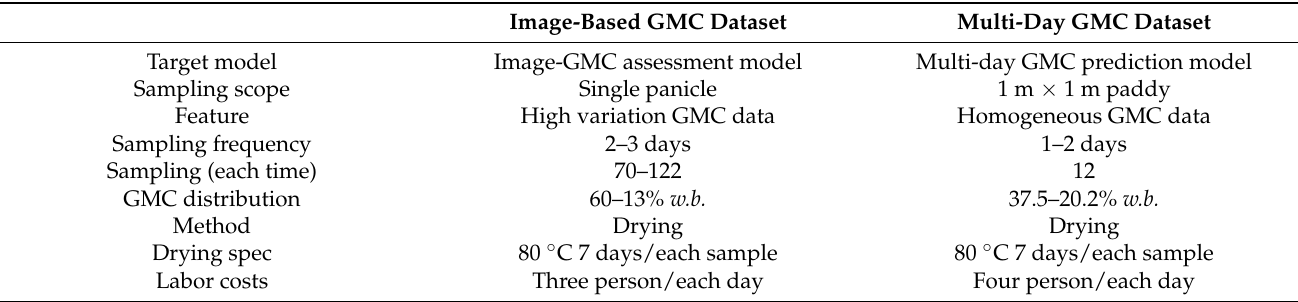
Table 7. Comparison of two on-site sampling